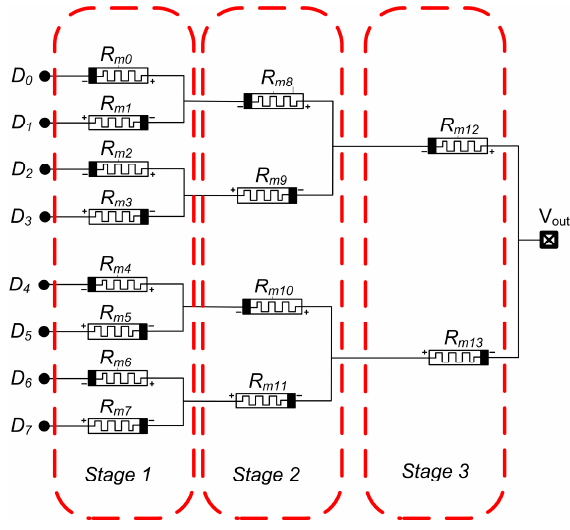
Figure 9. An eight level input memristor-based DAC circuit.